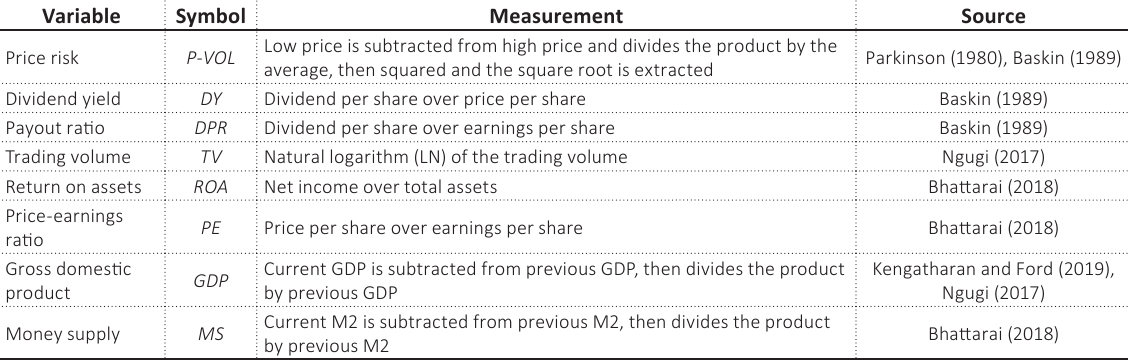
Table 1. Variable